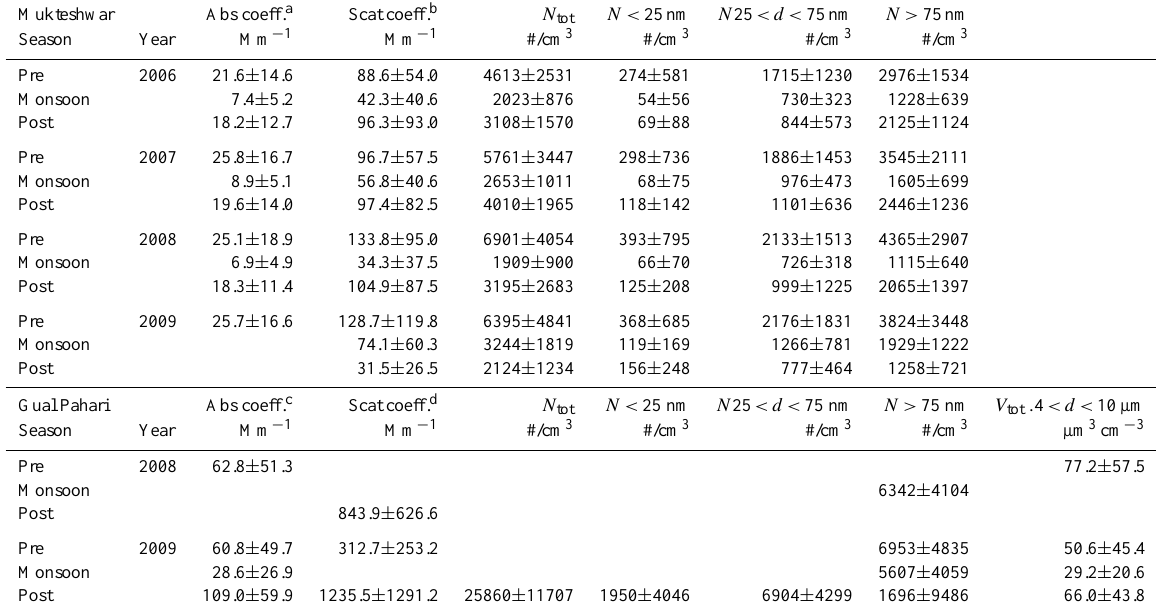
Table 1. Pre-monsoon, monsoon and post-monsoon average aerosol properties in Mukteshwar and Gual Pahari. 30% hourly data coverage is demanded. ± denotes standard deviation calculated from the hourly data.